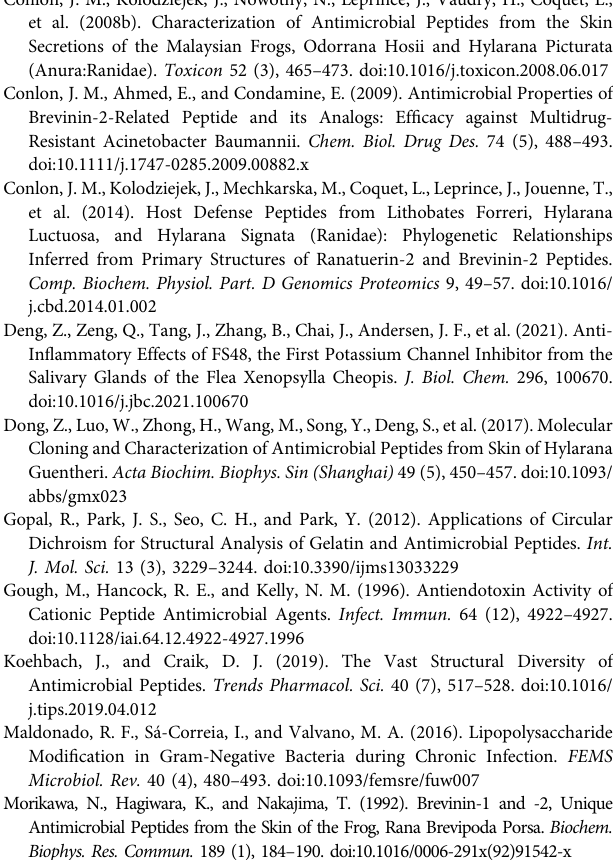
Supplementary Figure S1 | RP - HPLC analysis of brevinin-2MP. Supplementary Figure S2 | MALDI-TOF-MS analysis of brevinin-2MP without the intramolecular disul fi de bond (A) and with the intramolecular disul fi de bond (B)